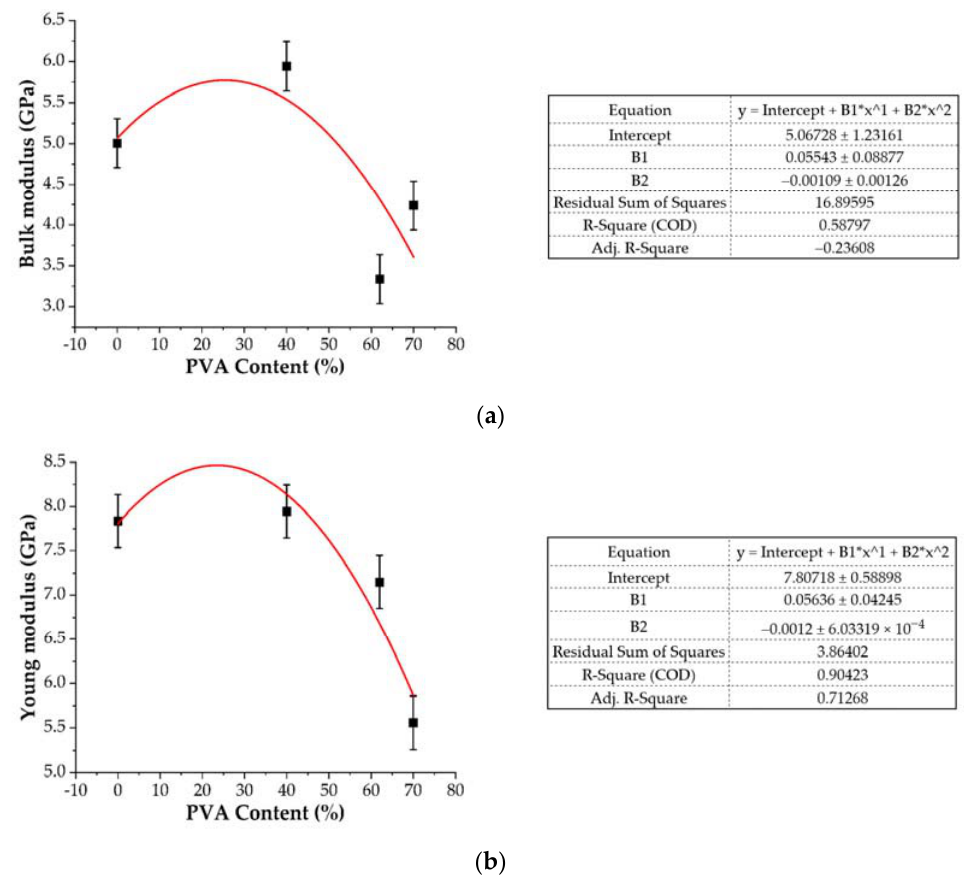
Figure 8. Bulk modulus ( a ) and Young’s modulus ( b ) of equilibrated structures vs. PVA content in gelatin/PVA hydrogels.